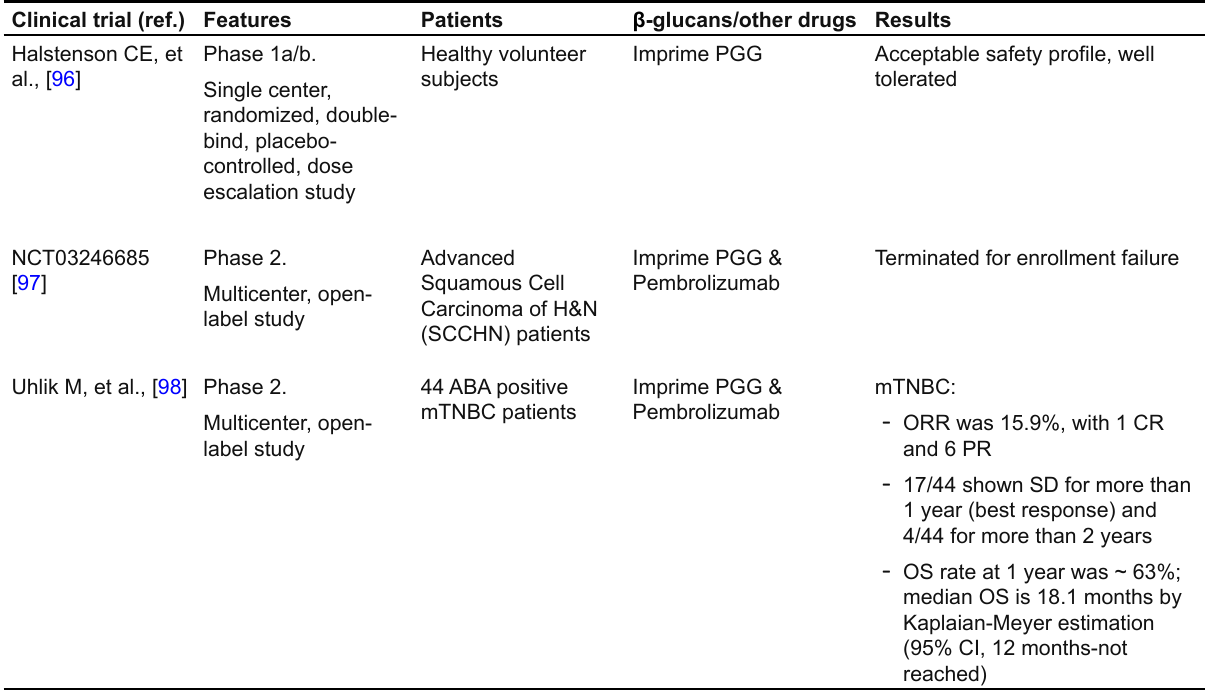
Table 2. Biological activity of most relevant β-glucans investigated in clinical studies Clinical trial (ref.) Features